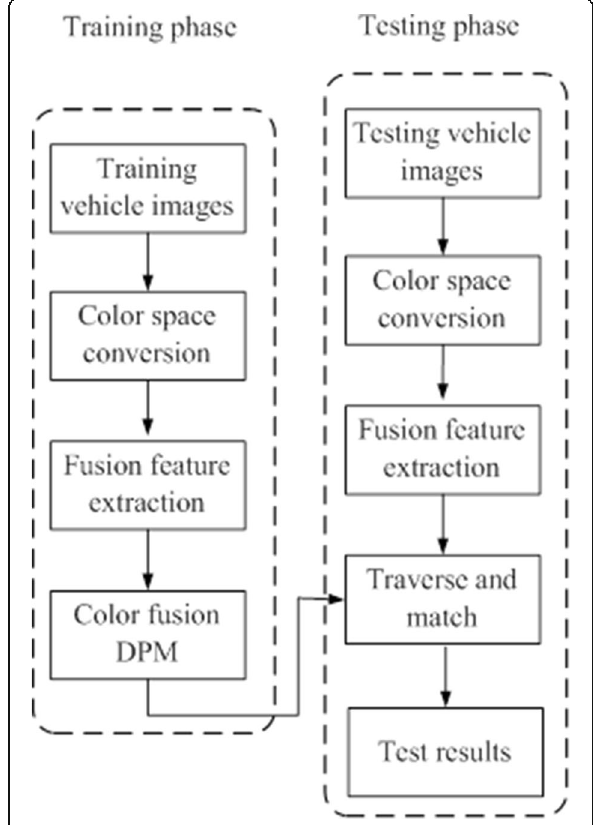
Fig. 1 Vehicle detection algorithm process based on color fusion